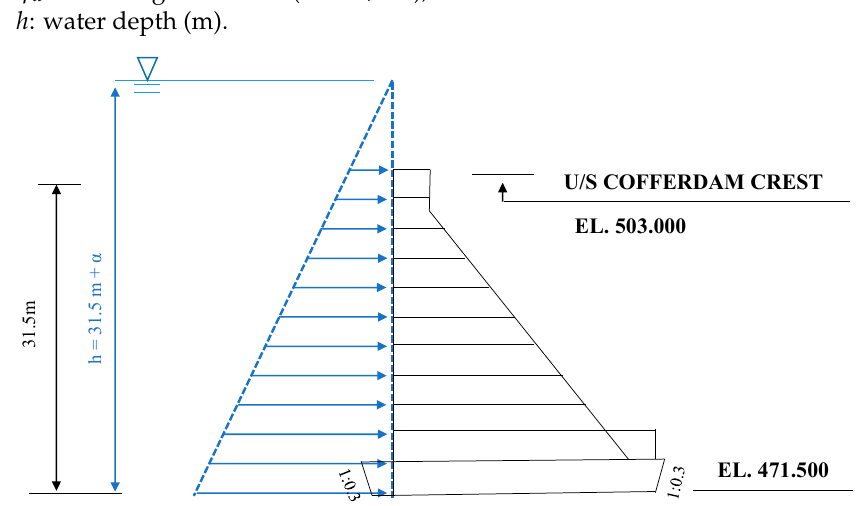
Figure 4. Headwater pressure when overflowing. (3) Uplift pressure.